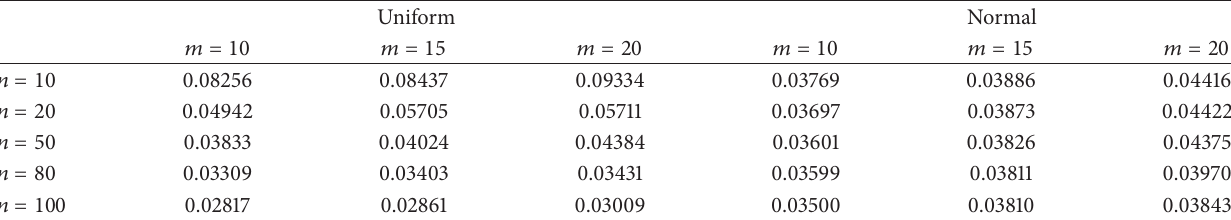
Table 5: Results of